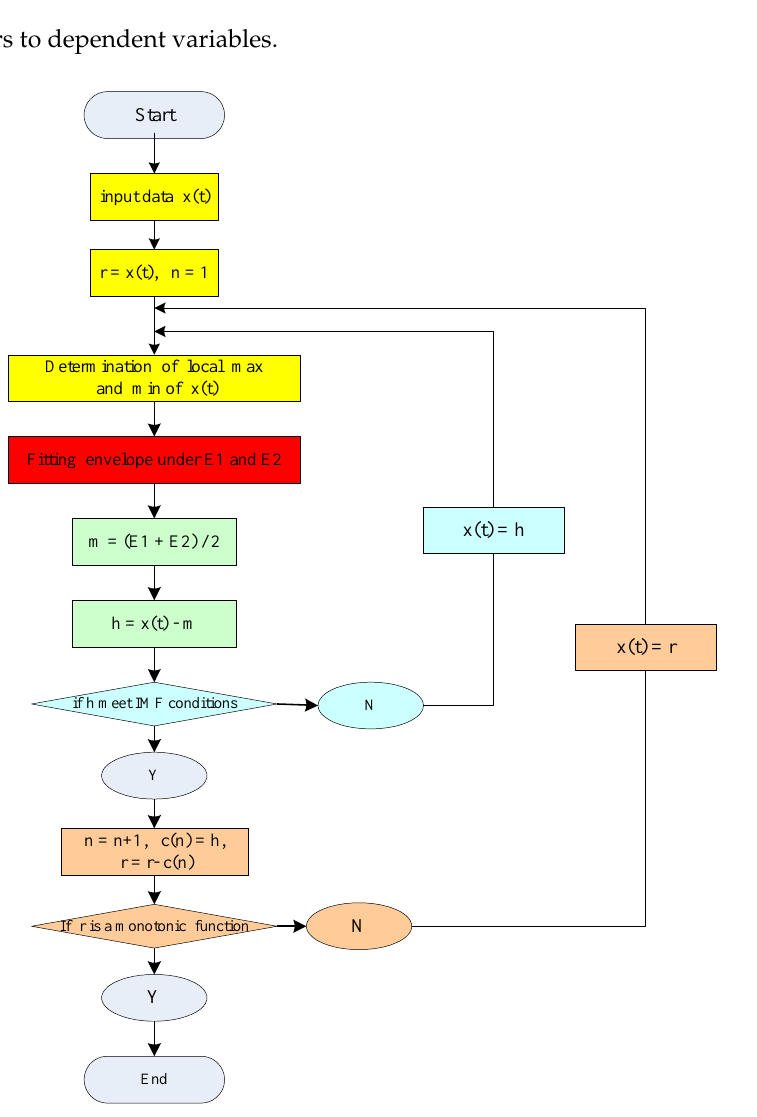
Figure 1. Differential EMD algorithm flowchart.